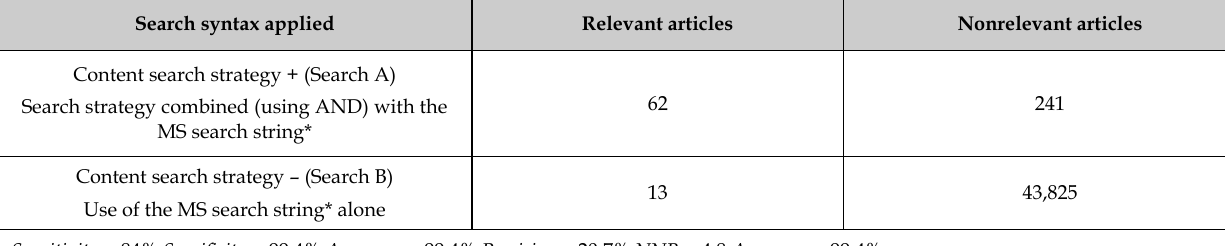
Table 4 Validation of the content search strategy and performance